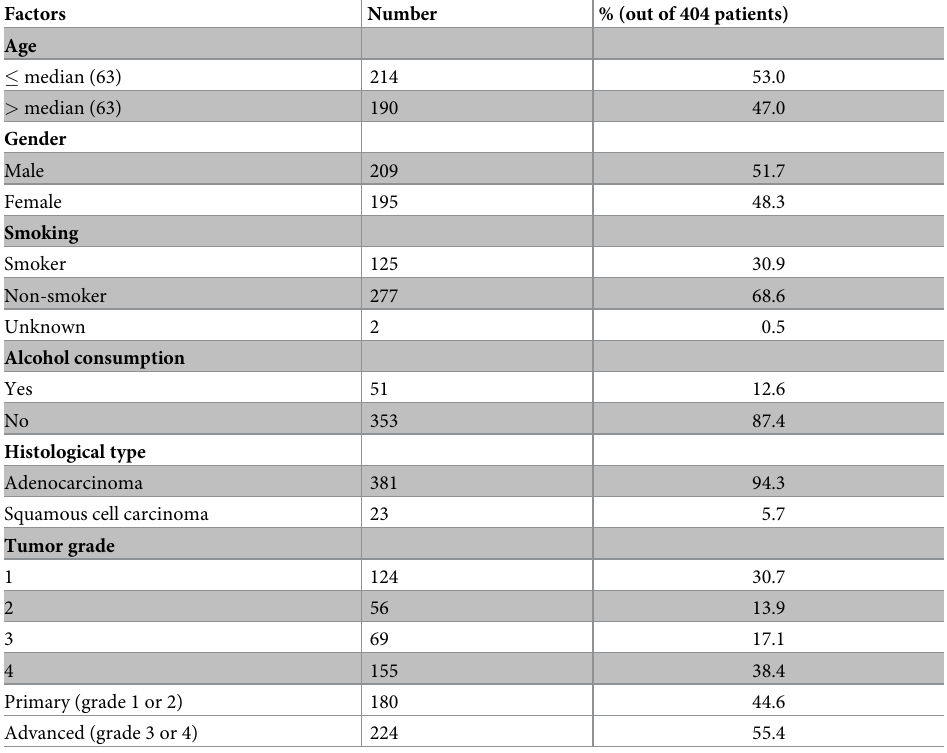
Table 1. Demographics of patients and tumor